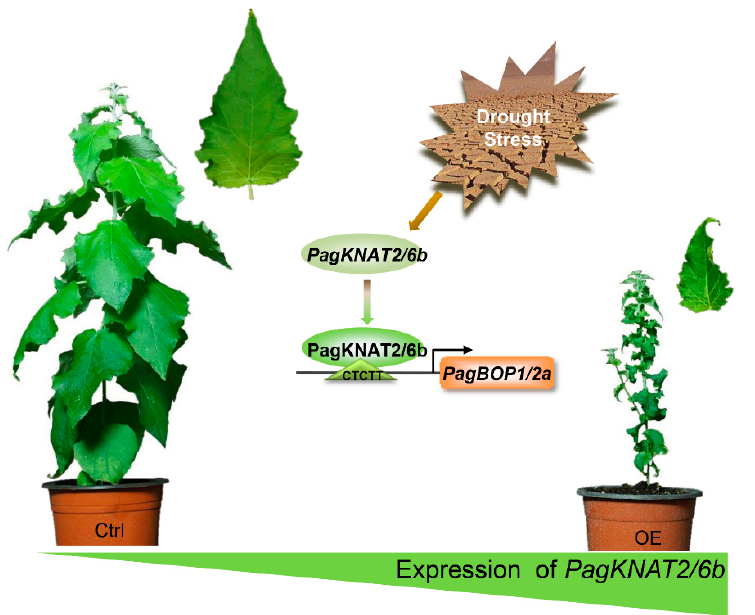
Figure 6. The PagKNAT2/6b-PagBOP1/2a regulatory module regulates leaf morphology under drought stress. The leaves receive drought signals and produce more PagKNAT2/6b proteins, which bind to the “CTCTT” element of the PagBOP1/2a promoter and activate the expression of PagBOP1/2a for the regulation of leaf development.